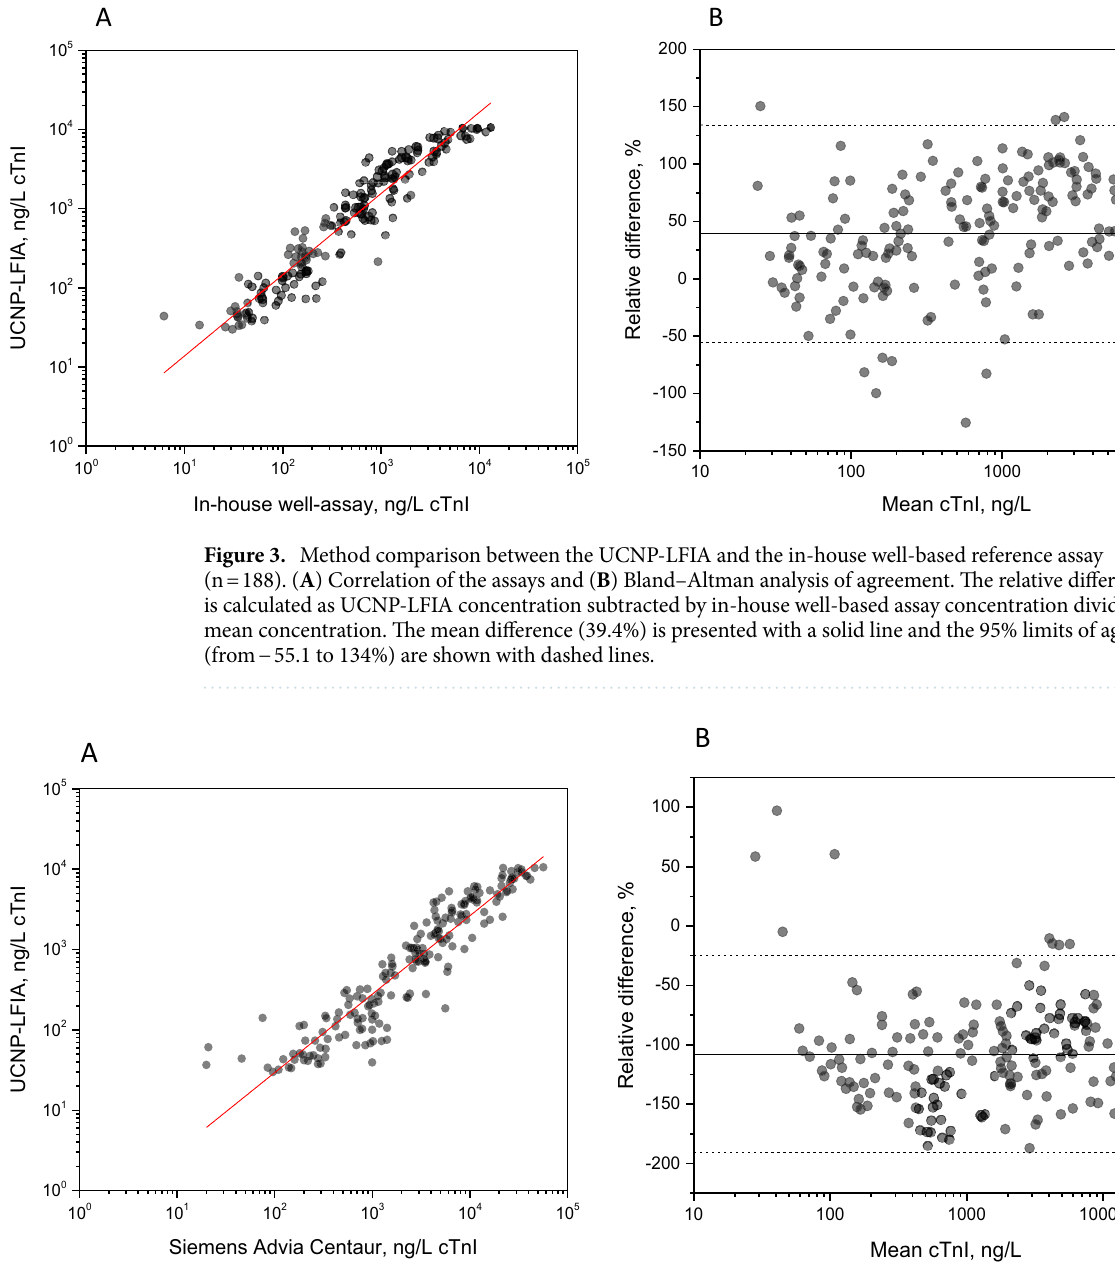
Figure 4. Method comparison between the UCNP-LFIA and Siemens Advia Centaur TnI-Ultra reference assay (n = 191). ( A ) Correlation of the assays and ( B ) Bland–Altman analysis of agreement. The relative difference is calculated as UCNP-LFIA concentration subtracted by Siemens Advia Centaur TnI-Ultra concentration divided by mean concentration. The mean difference (− 107.7%) is presented with a solid line and the 95% limits of agreement (from − 25.1 to − 190.4%) are shown with dashed